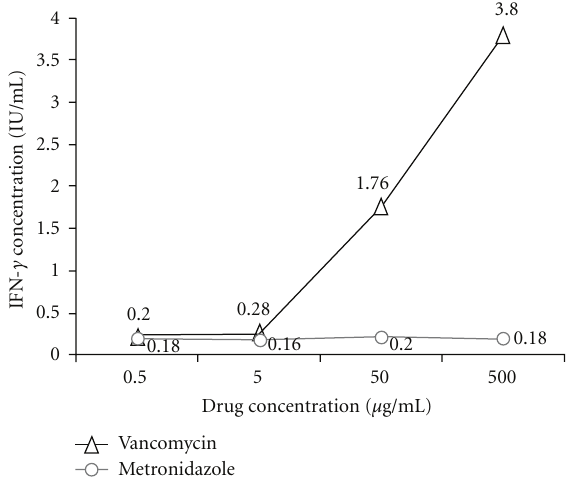
Figure 1: Secreted fraction of INF- γ production by the patient’s peripheral lymphocytes after 18 h stimulation with various concen- trations of Vancomycin and Metronidazole. The patient did not produce any detectable levels of INF- γ with Ceftriaxone, Amox- icillin, and Meropenem stimulation at all drug concentrations ( < 0.16IU/mL). Likewise, the levels of INF- γ production in Vanco- mycin-na¨ıve control subject were below the threshold of detection ( < 0.16IU/mL) at all Vancomycin